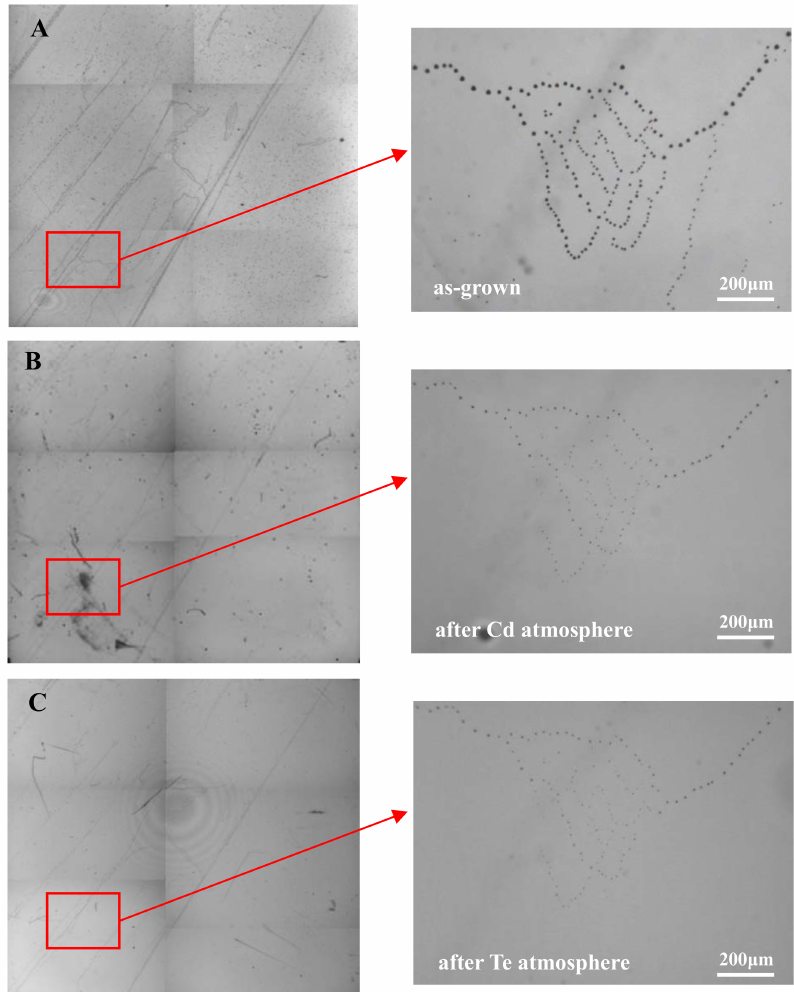
Figure 4. IR images of CMT:In crystals before and after annealing: ( A ) as-grown; ( B ) after Cd atmosphere annealing at 873 K for 240 h; ( C ) after Te atmosphere annealing at 773 K for 120 h. The size of the images is 9 × 9 mm 2